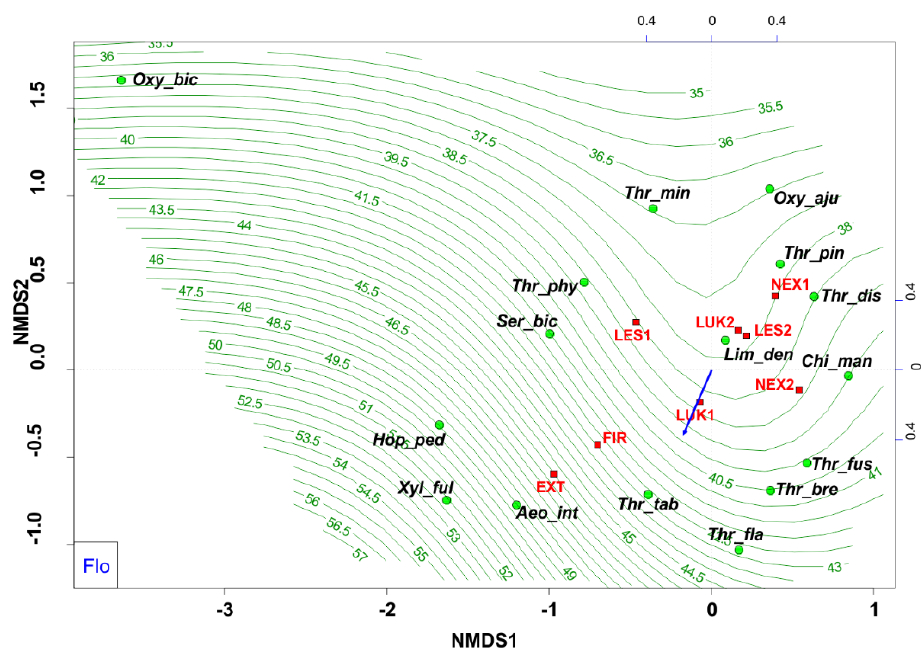
Figure 4. Nonmetric multidimensional scaling (NMDS) plot showing the relatedness of the thrips assemblages between the different samples and study plots (EXT, FIR, NEX1, NEX2, LUK1, LUK2, LES1, LES2) and the present of floricolous species . Oxy_bic– Oxythrips bicolor , Oxy_aju– Oxythrips